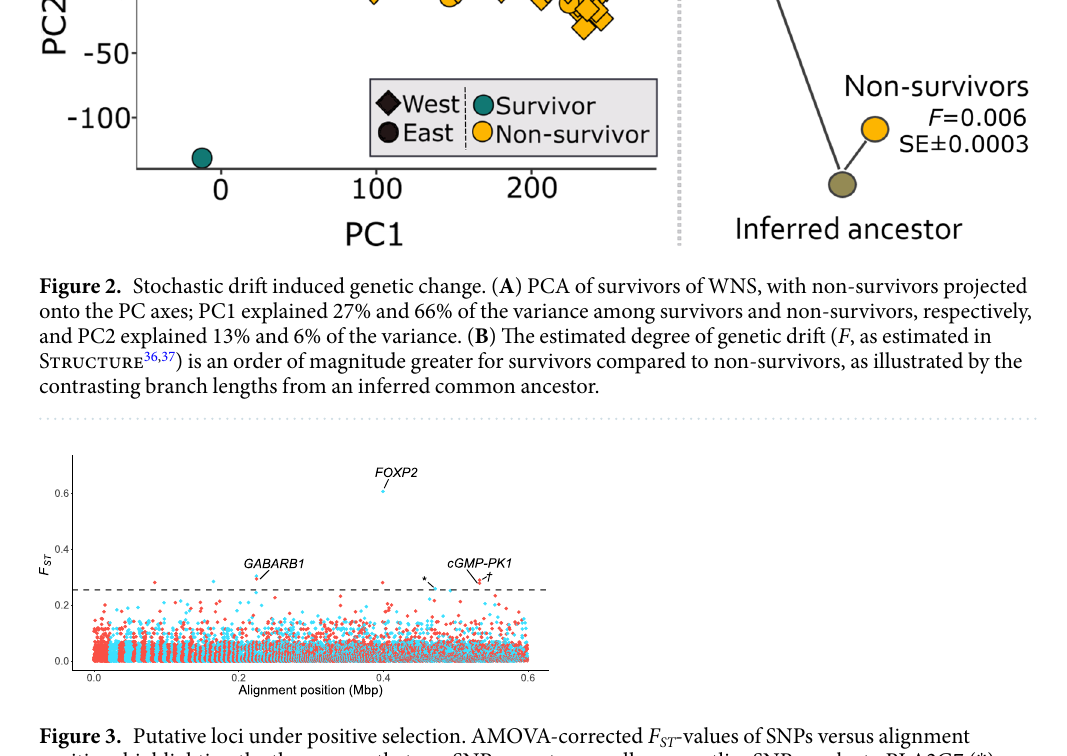
Figure 3. Putative loci under positive selection. AMOVA-corrected F ST -values of SNPs versus alignment position, highlighting the three genes that our SNPs map to, as well as an outlier SNP nearby to PLA2G7 ( * ), and the outlier SNP which is adjacent to CGMP-PK1 ( † ). The dashed line marks the significance threshold and alternating colors indicate different genomic scaffolds (1,214 in our